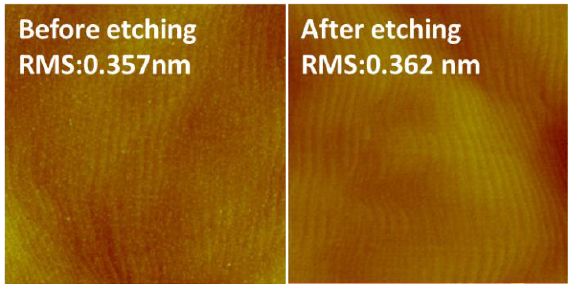
Figure 2. Atomic force microscopy (AFM) images of the surface before etching and after etching of 5×5 μm 2 .